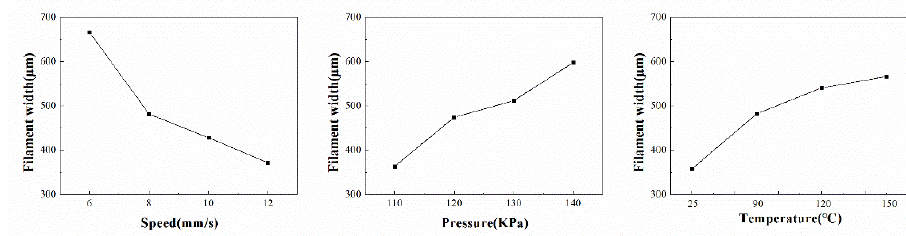
Figure 6. Trend graphs of the orthogonal experiment on the filament width experiment.